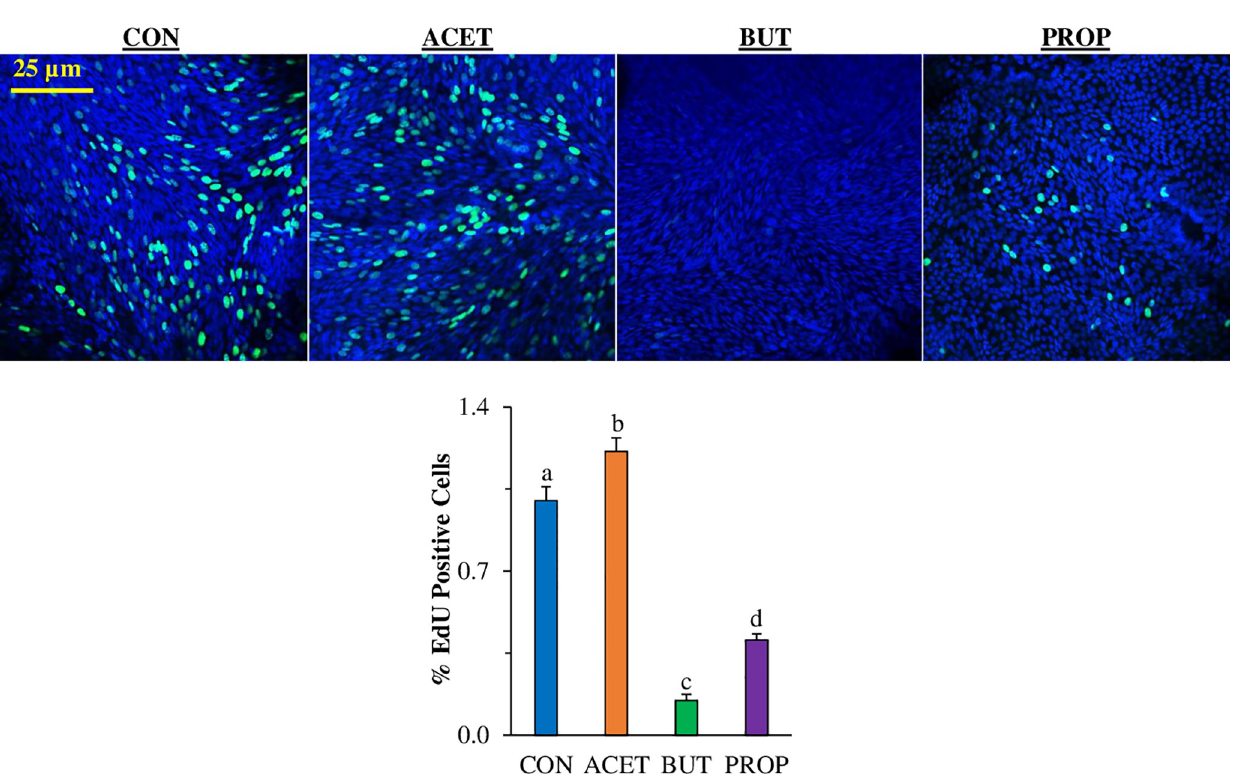
Fig 5. Effect of 24 h treatment with 10 mM acetate (ACET), butyrate (BUT), or propionate (PROP) on 3D (a) and 2D (b) human small intestinal enteroid cell proliferation (EdU staining, green) compared to controls (CON). Nuclei are stained with DAPI (blue) and images are representative of several fields of view at 20X magnification. Treatments are compared to controls (CON) which are set to 1.0 and superscripts (a,b,c,d) indicate statistical significance between treatments at P < 0.05, n =